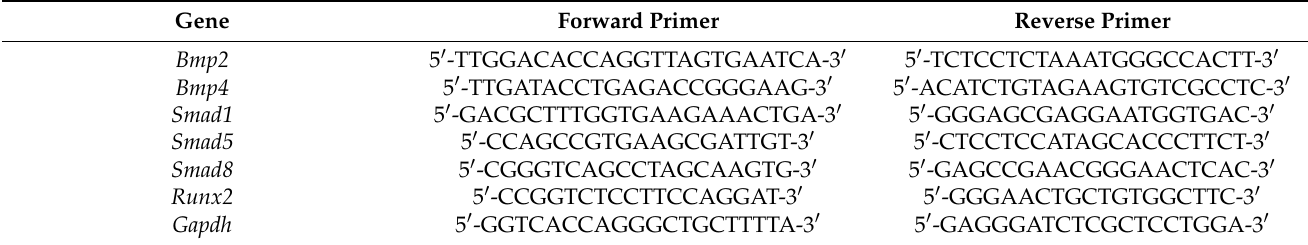
Table 1. PCR primers of the key genes in the BMP/Smad